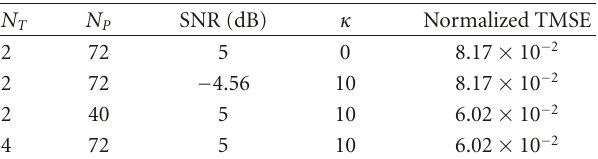
Table 4: Substantial benefits of Rician fading MIMO channel by using MMSE estimator ( L =